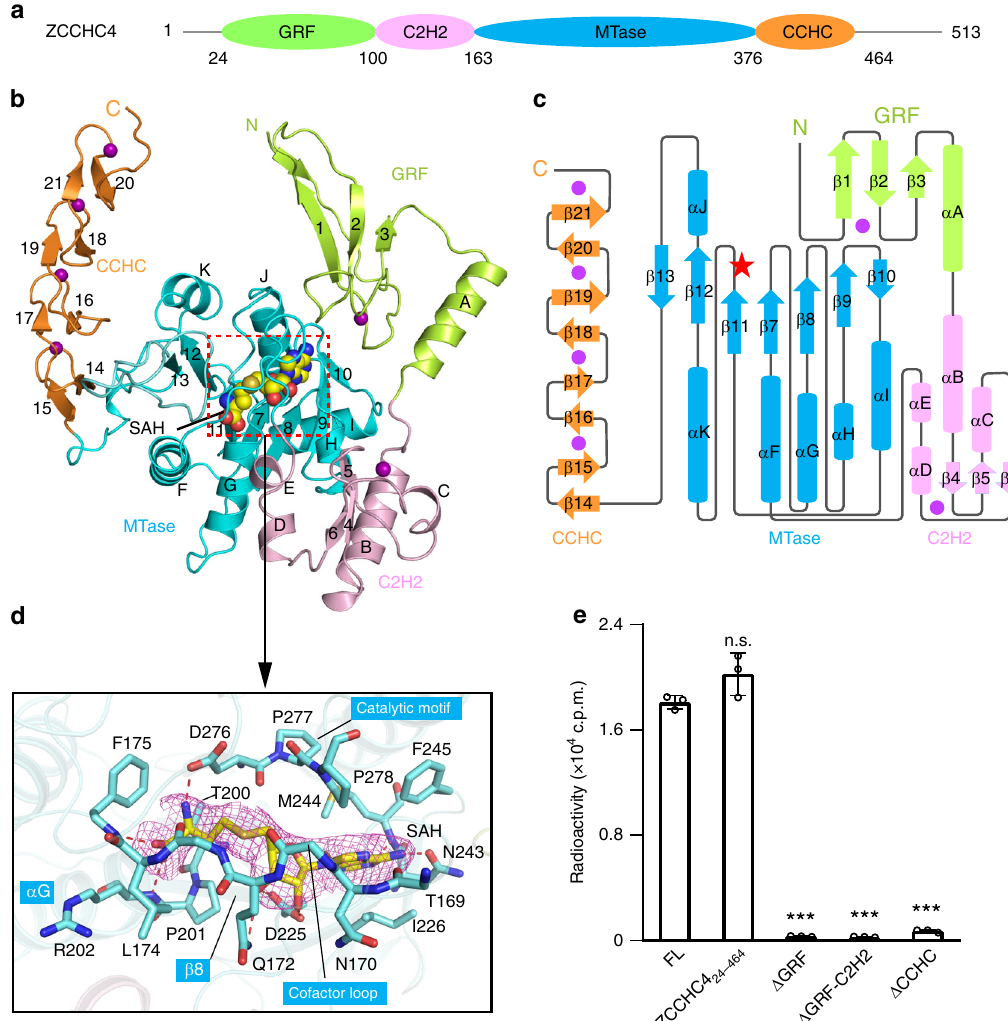
Fig. 1 Crystal structure of ZCCHC4. a Domain architecture of ZCCHC4, with individual domains indicated by residue numbers. b Ribbon representation of ZCCHC4 24-464 bound to SAH, with the β -strands and α -helices numbered numerically and alphabetically, respectively. The zinc ions are shown as purple spheres. c Schematic representation of the structure of ZCCHC4. The zinc ions are represented by purple spheres. The catalytic site is marked with red star. d Close-up view of the interaction between ZCCHC4 (cyan) and SAH (yellow), with hydrogen-bonding interactions depicted as dashed lines and the Fo – Fc omit map (magenta) of SAH contoured at 3 σ level. e Methylation activity of full-length (FL), core (ZCCHC4 24-464 ) or domain-truncated ZCCHC4. The data are mean ± SD. Statistical analysis used two-tailed Student ’ s t test for the difference from FL: *** p < 0.001. n.s., not signi fi cant. Source data are provided as a Source Data fi